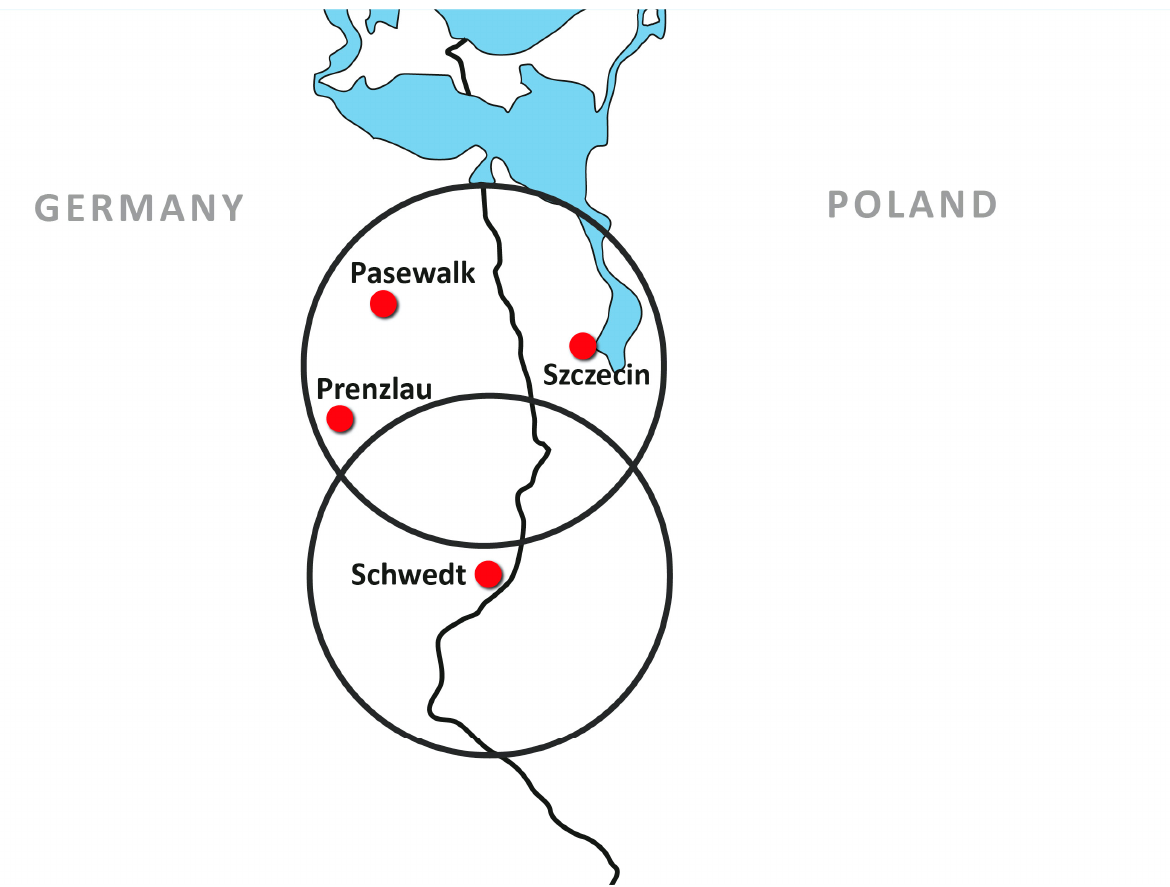
Figure 1. Influence of the boundary between Germany and Poland on the catchment areas of hospitals in the cities of Szczecin, Pasewalk, Prenzlau and Schwedt. It is apparent that the hospitals close to the border have small catchment areas and that there are areas without easily accessible hospitals.